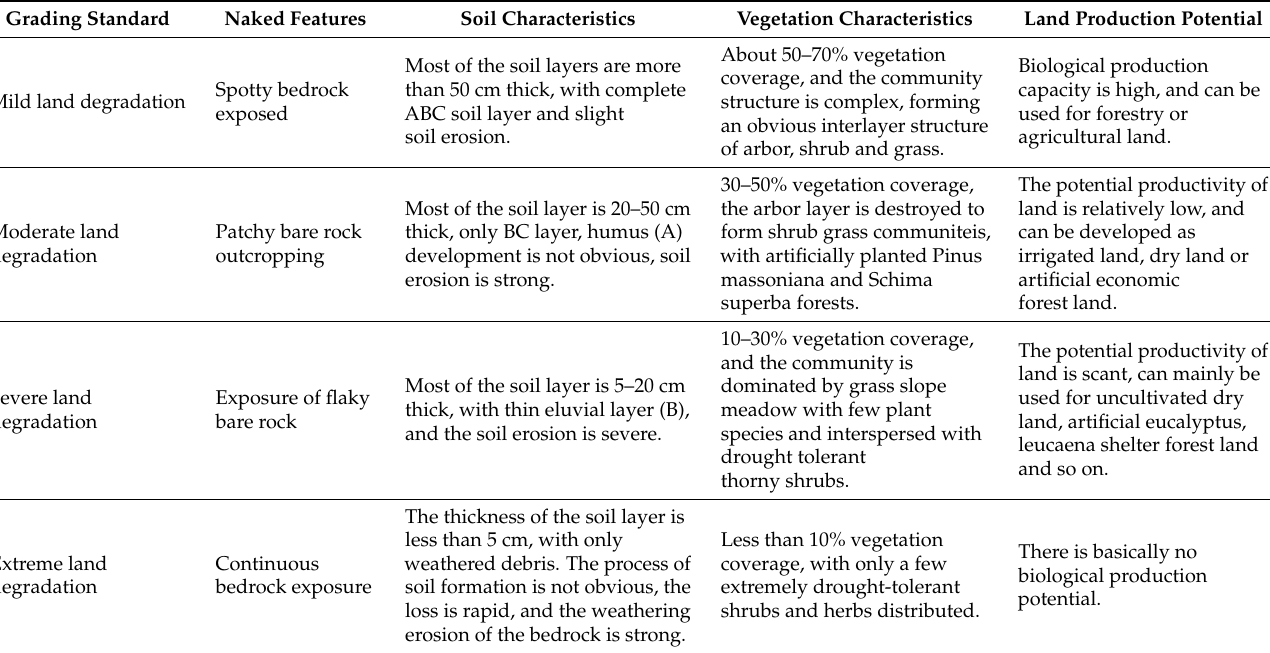
Table 1. Classification of red bed land degradation at landscape